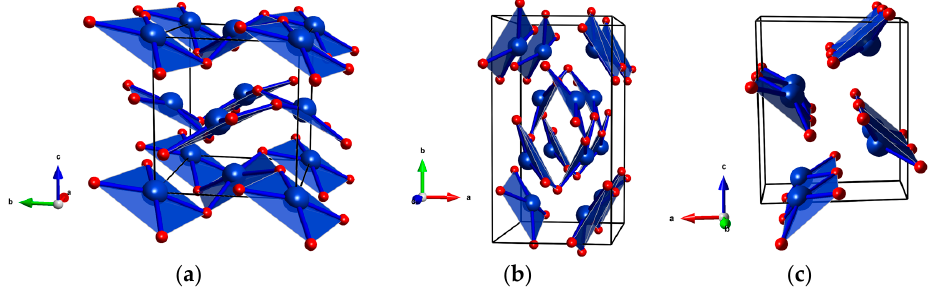
Figure 5. Possible high-pressure structures of CuF 2 ( a ) Pca2 1 ( Z = 4); ( b ) Pbcn ( Z = 8); and ( c ) Pnma ( Z = 4). For clarity only the four shortest Cu-F bonds are shown.